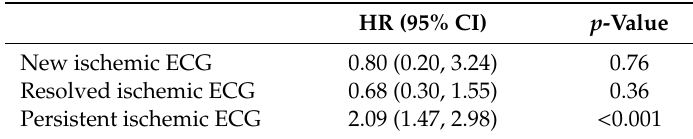
Table 3. Unadjusted hazard ratios (HR) for composite